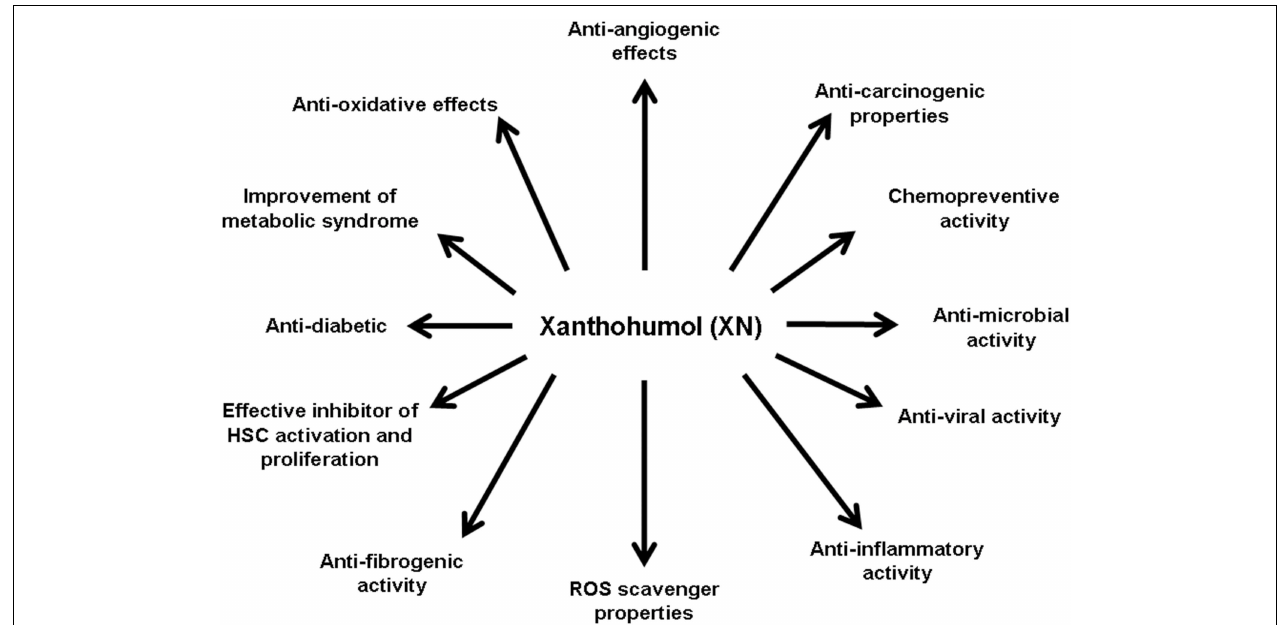
FIGURE 2 | Biological effects of xanthohumol. Xanthohumol (XN) has been shown to have wide spectrum of biological effects, by which it may also affect different pathophysiological mechanisms involved in the development and progression of chronic liver disease. Studies have shown that XN acts anti-angiogenic ( Albini et al., 2006; Shamoto et al., 2013), anti-carcinogenic (Dorn et al., 2010a,b,c; Araujo et al., 2011), chemopreventive (Miranda et al., 2000c; Gerhauser et al., 2002; Dorn et al., 2010a ), anti-microbial (Gerhauser and Frank, 2005; Rozalski et al., 2013; Kramer et al., 2015), anti-viral